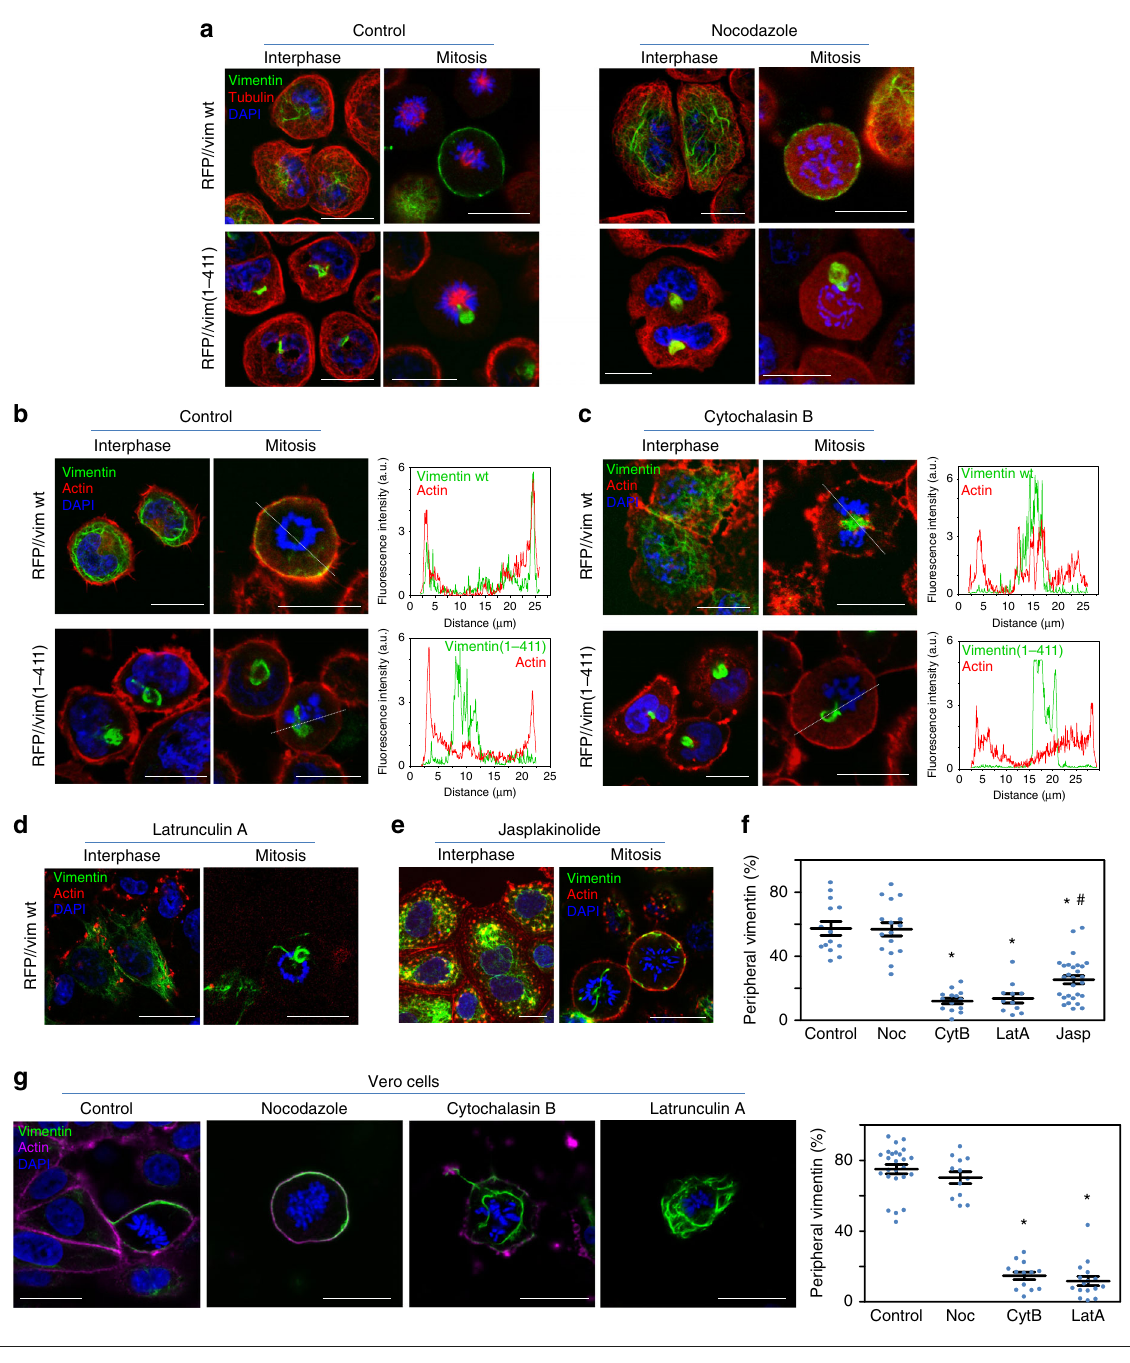
Fig. 3 Effect of microtubule or actin fi lament disruption on the distribution of vimentin wt and vimentin(1-411). a – d The distribution of vimentin and tubulin or f-actin was assessed in interphase and mitotic cells. a SW13/cl.2 cells transfected with RFP//vimentin wt or (1-411) to express untagged vimentin proteins, were treated in the absence or presence of 5 µ M nocodazole for 30 min in serum-free medium. Vimentin (green) and tubulin (red) were visualized by immuno fl uorescence. b , c SW13/cl.2 cells were transfected as above, cultured in the absence b or presence c of 10 µ g/ml cytochalasin B for 30 min in serum-free medium. Vimentin (green) was visualized by immuno fl uorescence and f-actin was stained with Phalloidin (red). Fluorescence intensity pro fi les of vimentin and actin along the dotted lines are shown in the right panels. d – f SW13/cl.2 cells transfected with RFP//vimentin wt were treated in serum-free medium with 2.5 µ M latrunculin A d or 50 nM jasplakinolide e for 30 min, and processed by immuno fl uorescence. Representative images of single sections taken at mid-height of interphase and dividing cells are shown. f Quanti fi cation of the proportion of vimentin located at the cell periphery upon disruption of microtubules or actin. Noc nocodazole; CytB cytochalasin B; LatA latrunculin A; Jasp jasplakinolide (* p < 10 − 7 vs. control; # p < 0.02 vs. CytB and LatA). h Vero cells were treated with the indicated agents and the distribution of endogenous vimentin and actin in mitotic cells was assessed as above. Graph shows the proportion of vimentin associated with the cell periphery (* p < 0.001 vs. control). The number of determinations for the experimental conditions shown in graphs from left to right was the following: f 14, 16, 14, 11, 28; g 25, 12, 13, 16. Average values ± SEM are shown. All p- values were obtained with two-tailed, unpaired Student ’ s t -test. Data are available in the Source Data fi le. Scale bars, 20 μ